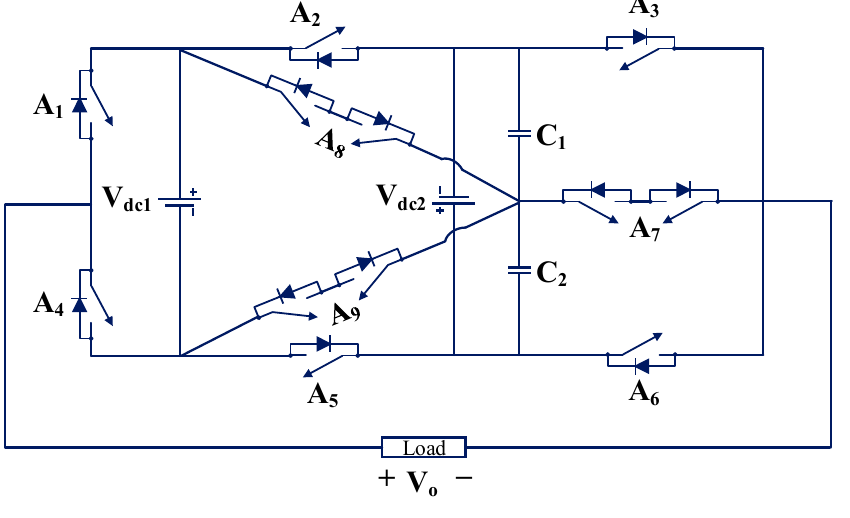
Figure 33. Single-phase seven-level FT MLI (TP36) [68].